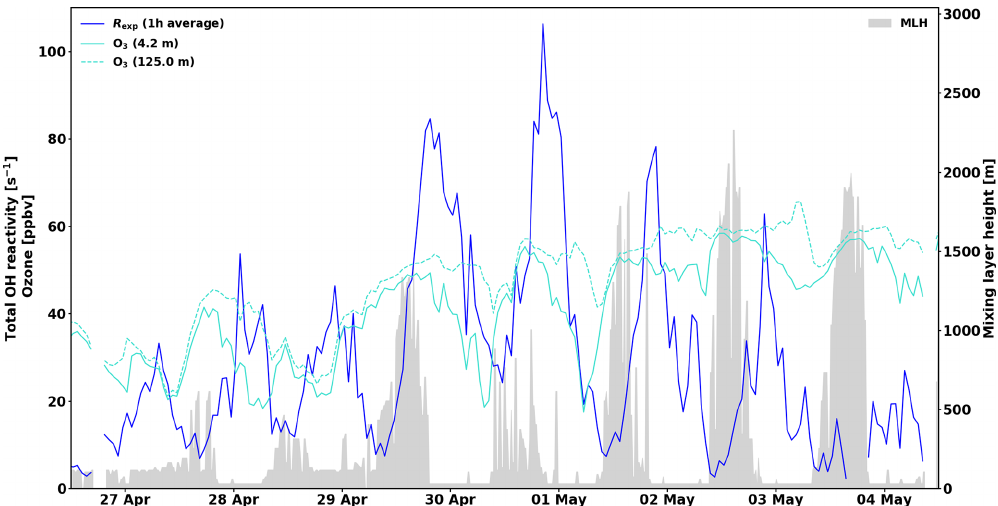
Figure 4. The 1h averages of total measured OH reactivity, R exp , and ozone mixing ratios at 4.2 and 125.0m above ground. Mixing layer height (MLH) is shown as a grey shadow. Note that the detection limit for MLH is 60m and values below this limit are displayed at 30m (and zeros denote gaps in the